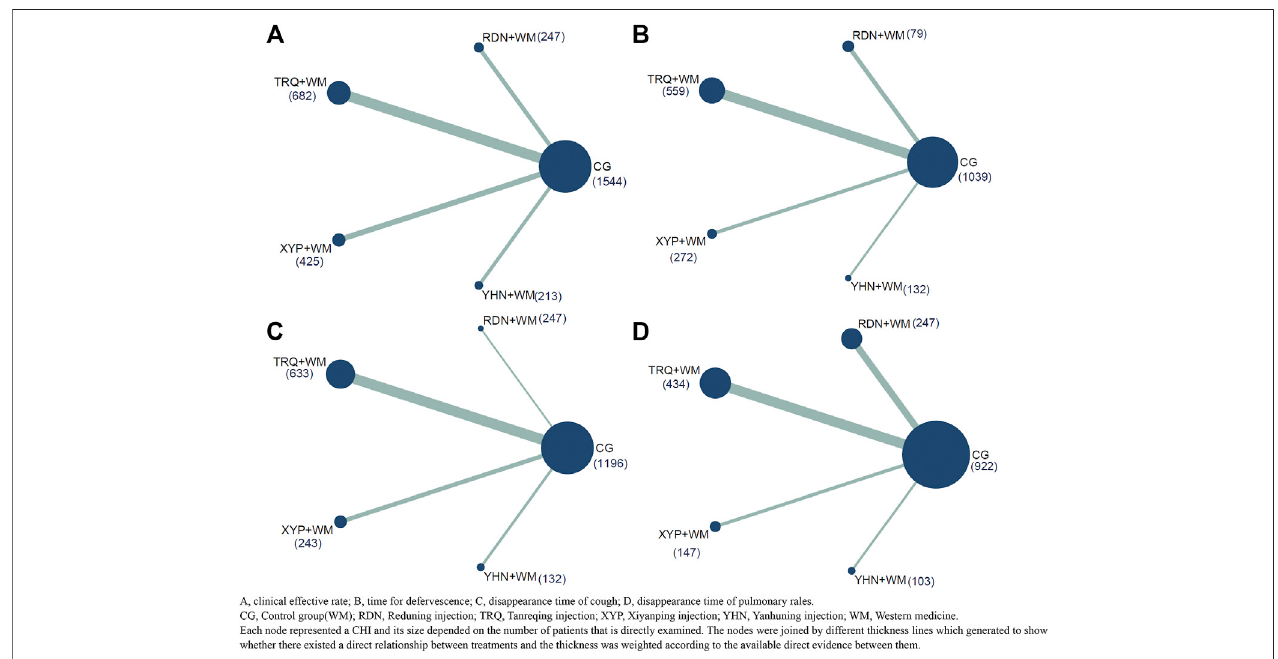
FIGURE 2 | Network plot of all the trials based on the outcomes. (A) Clinical effective rate; (B) time for defervescence; (C) disappearance time of cough; (D) disappearancetimeofpulmonaryrales.CG,Controlgroup;RDN,Reduninginjection;TRQ,Tanreqinginjection;XYP,Xiyanpinginjection;YHN,Yanhuninginjection;WM, Westernmedicine.EachnoderepresentedaCHIanditssizedependedonthenumberofpatientsthatisdirectlyexamined.Thenodeswerejoinedbydifferentthickness lines which generated to show whether there existed a direct relationship between treatments and the thickness was weighted according to the available direct evidence between them.